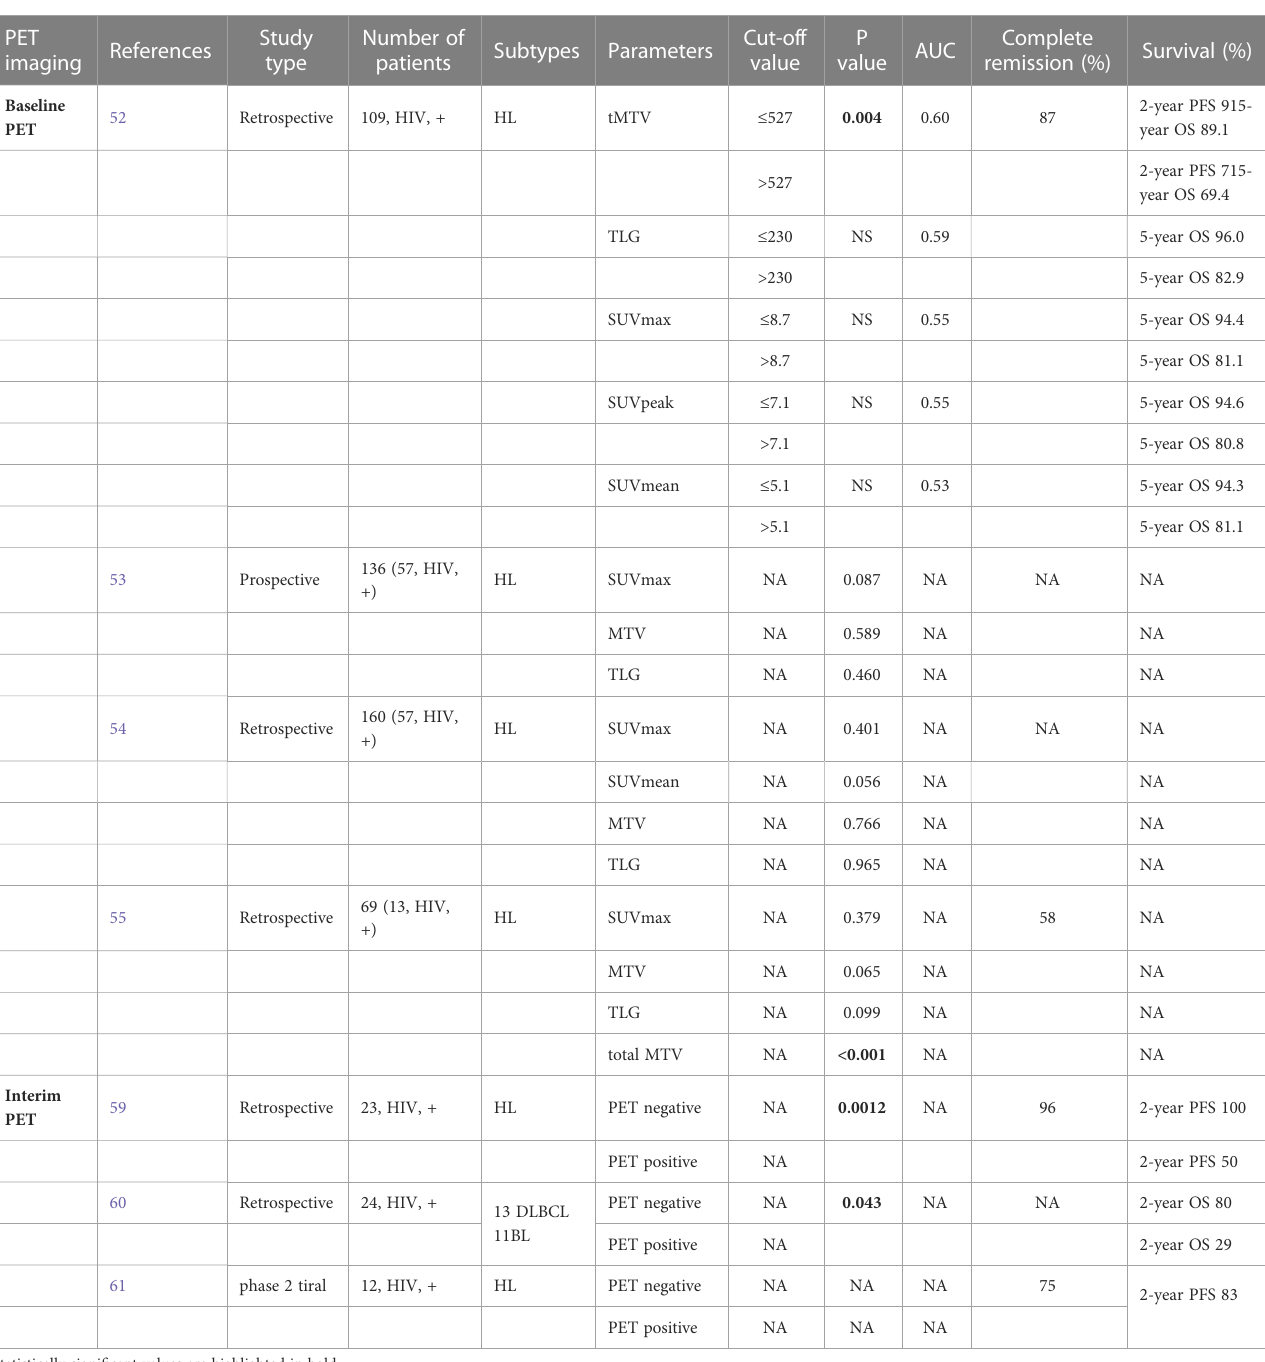
TABLE 2 The prognostic predictions of both baseline and interim FDG PET for HIV-associated lymphoma. PET